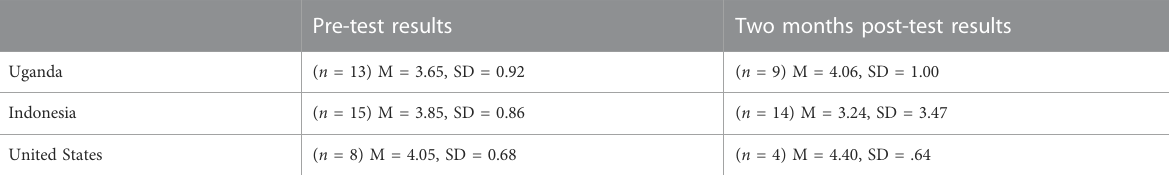
TABLE 3 Comparative results of the New Ecological Paradigm.